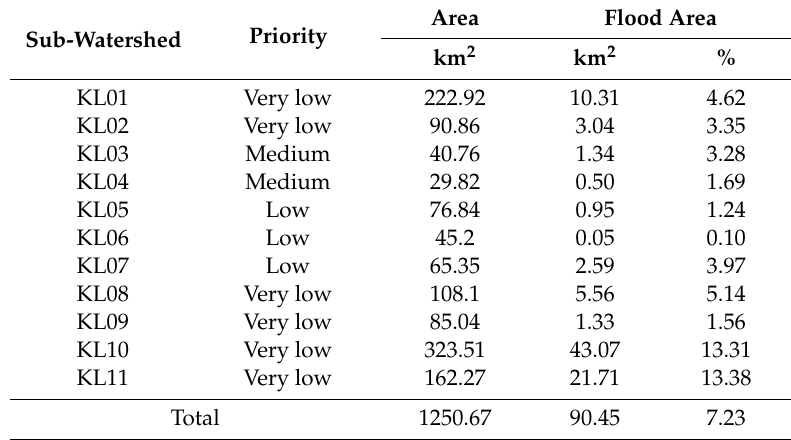
Table 7. The flood area proportion of KLs watershed area on August 29–31,